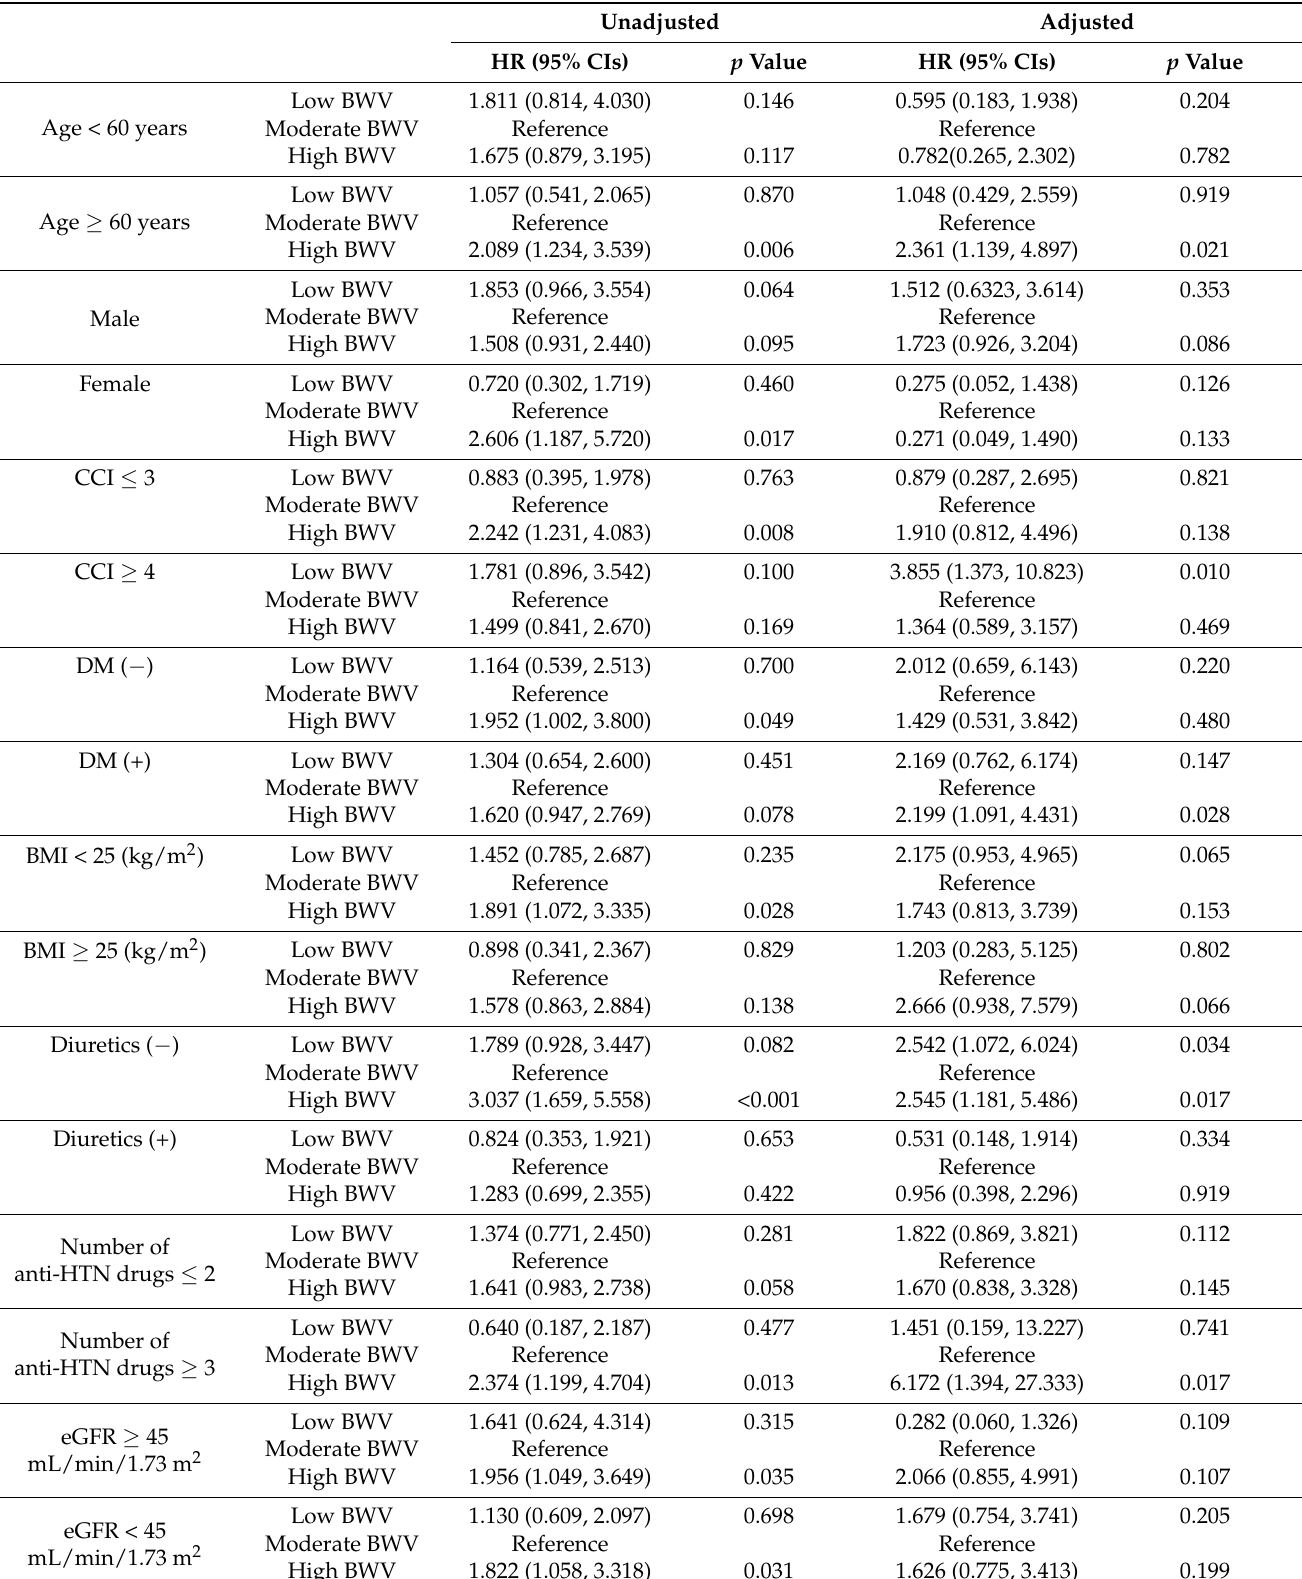
Table 3. Cox proportional hazards regression of BWV for the composite outcome in various subgroups.